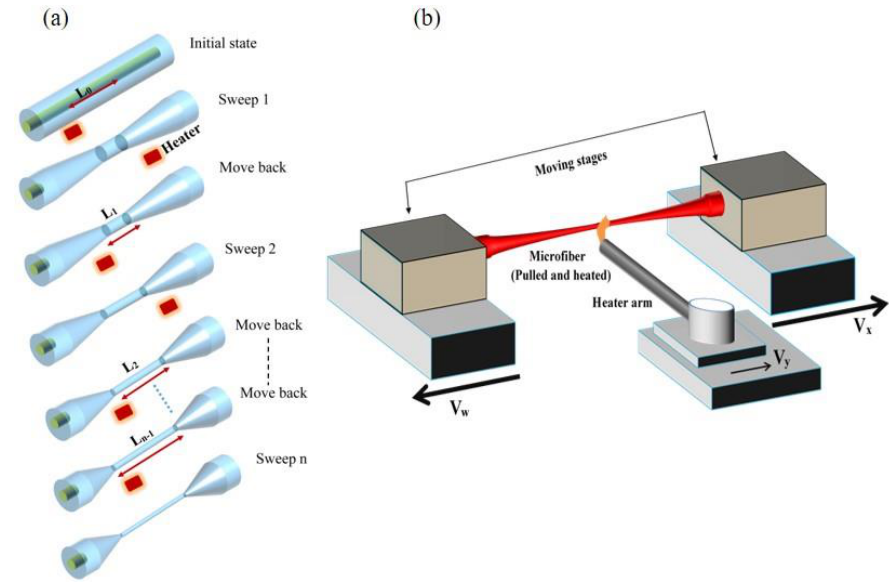
Figure 3. Schematic of ( a ) taper profile evolution using the multi-sweep tapering method; ( b ) Experimental implementation of the single-sweep tapering method.